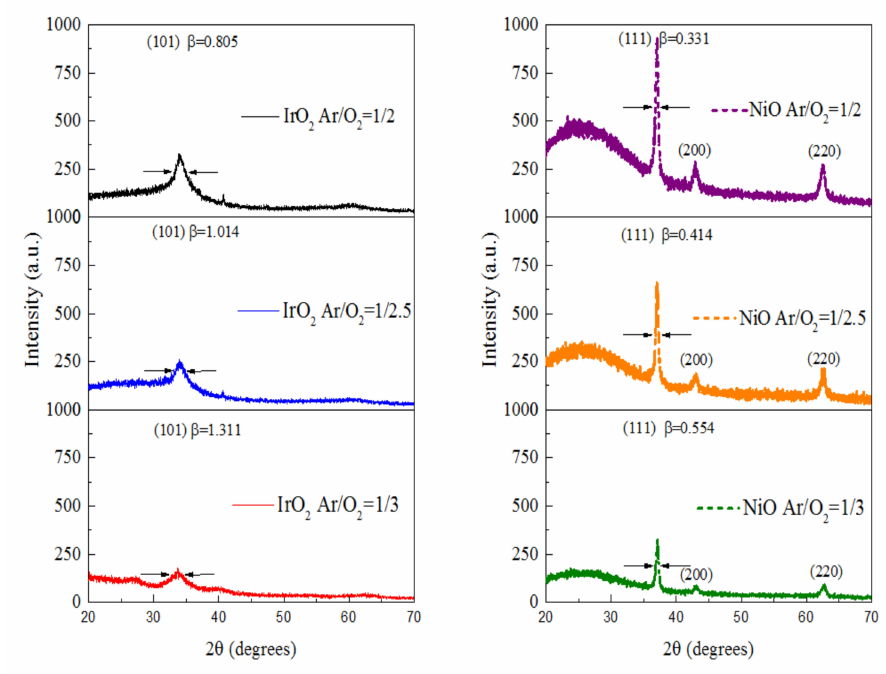
Figure 4. X-ray diffraction of IrO 2 and NiO electrodes at various Ar/O 2 mixing